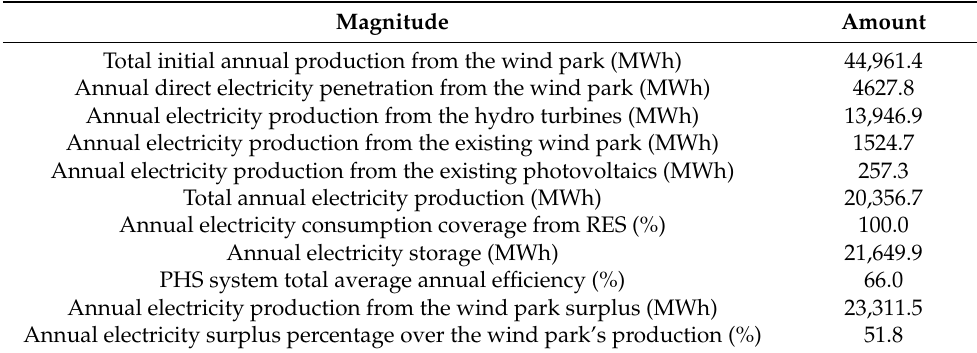
Table 3. Analysis of the annual electricity production on Sifnos in